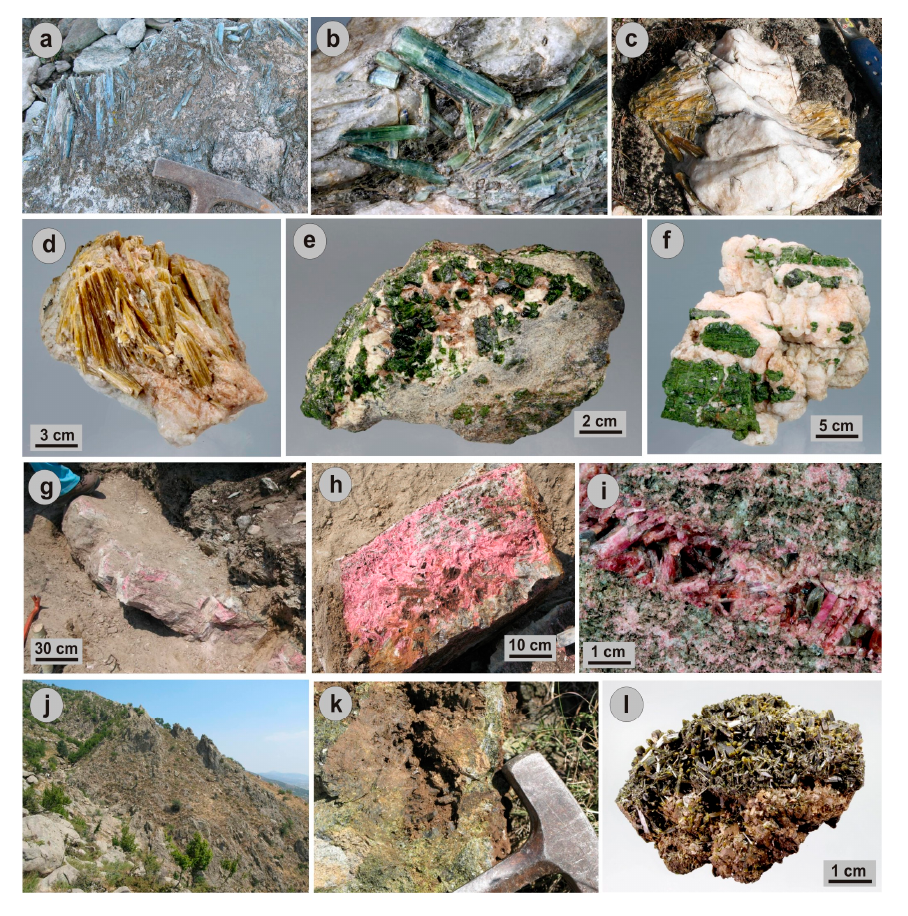
Figure 6. Field and hand specimens photographs demonstrating occurrences and crystals of gem- quality Al 2 SiO 5 -polymorphs and epidote-group minerals of Greece: ( a–d ) Blue, green to orange kyanite within metapelites and quartz veins at Trikorfo, Thassos Island; ( e,f ) Mn-rich andalusite (var. viridine) in quartz from Trikorfo, Thassos Island; ( g–i ) Pink-red, Mn-bearing zoisite/clinozoisite from Trikorfo, Thassos Island. ( j ) Epidote-bearing skarn of Lefkopetra, Kimmeria/Xanthi. Granodiorite is at the front of the photo; ( k,l ) Green epidote crystals associated with andradite from Lefkopetra; Photographs 6b,d,e,f,i,l are courtesy of Berthold Ottens.